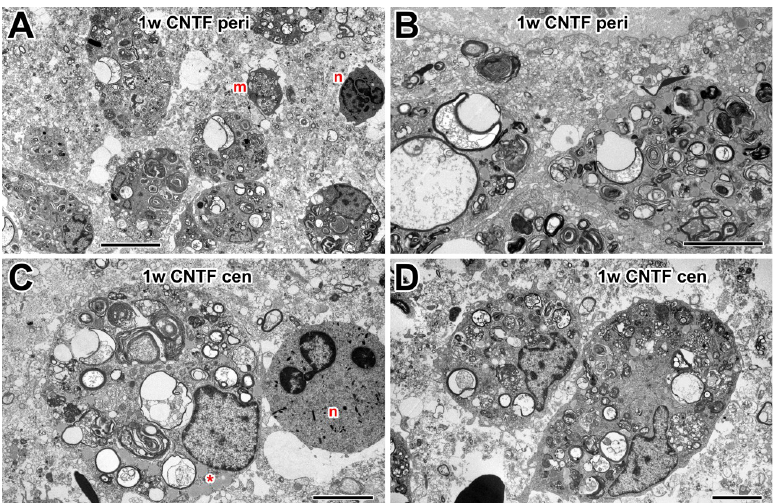
Fig 5. Electron microscopy of macrophages in 1 w CNTF-treated nerve. (A) Low power electron micrograph of the optic nerve periphery, showing numerous macrophages containing large debris-filled vacuoles. Also present are smaller microglia (m) and neurotrophil-like cells (n). (B) Active macrophages, with many large vacuoles, at nerve periphery. (C) Central macrophage with multiple phagocytic vacuoles, multilamellar bodies and also lipid inclusions (asterisk). Next to it is a neutrophil-like cell (n). (D) Centrally located macrophages with numerous multilamellar and multivesicular bodies. Scale bar: 10 μ m in A; 5 μ m in B, C, D.